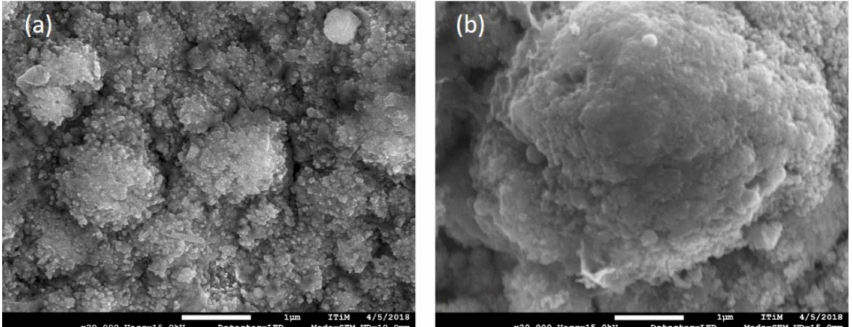
Figure 3. Top-view HR-SEM images for obtained coatings ( a ) Ti_10_100, ( b ) Ti_10_400. Scale bar = 1 µ m.